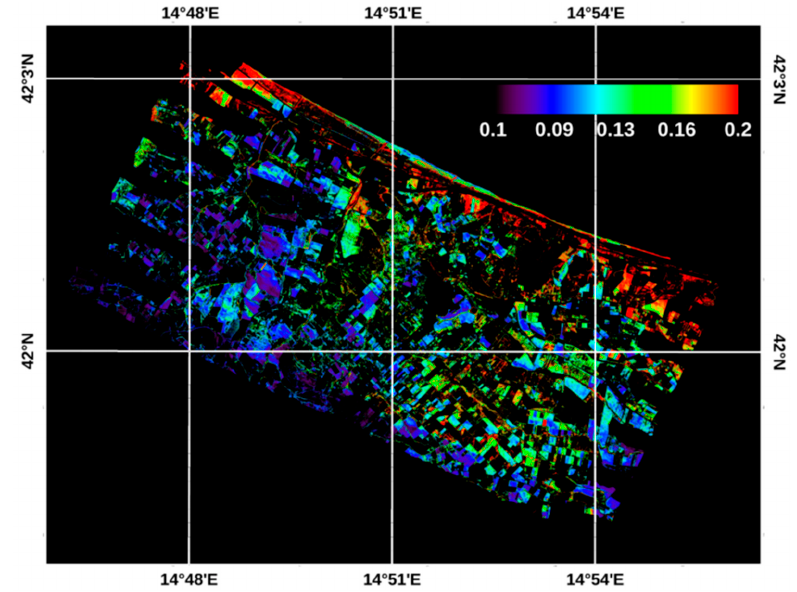
Figure 7. ATI map of the poorly vegetated and bare soils of the study area. The ATI values in the legend are expressed in K − 1